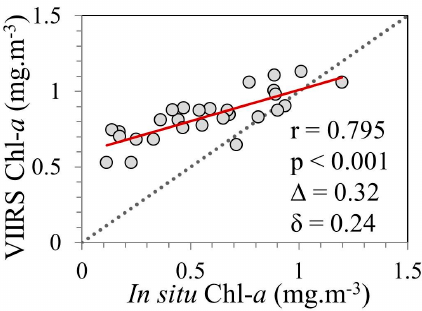
Figure 6. Correlation between in situ and satellite-derived Chl -a data in the Arabian Gulf. Chl -a were log 10 -transformed. For sample stations see Figure 1a.